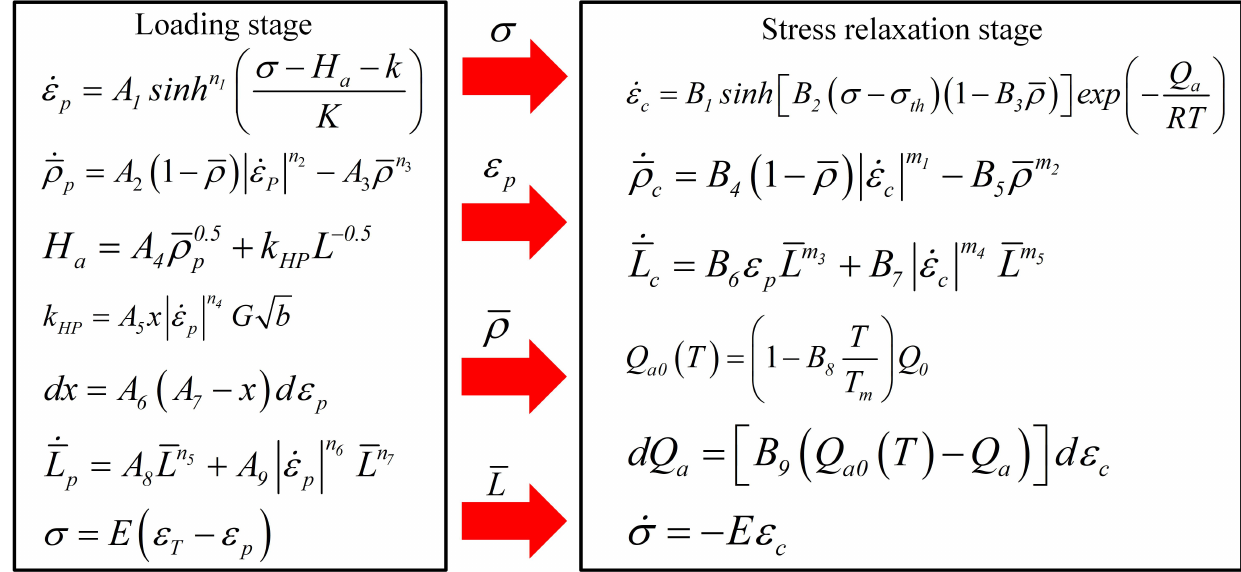
Figure 9. Modeling procedure for the constitutive model of multi-stage stress relaxation